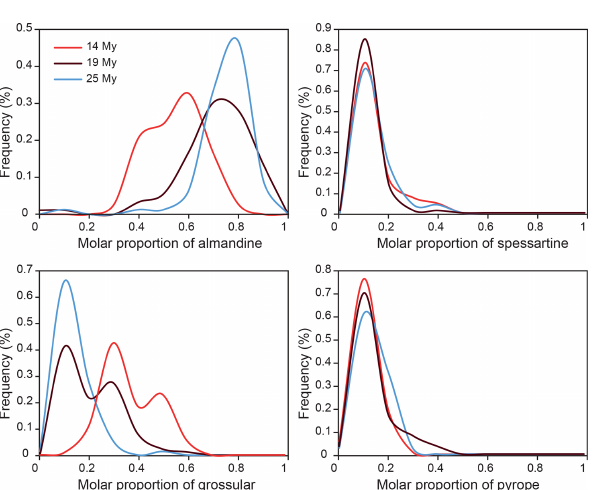
Figure 5. Relative frequency of the four most common endmembers almandine, grossular, spessartine, and pyrope in the three detrital samples from the Molasse